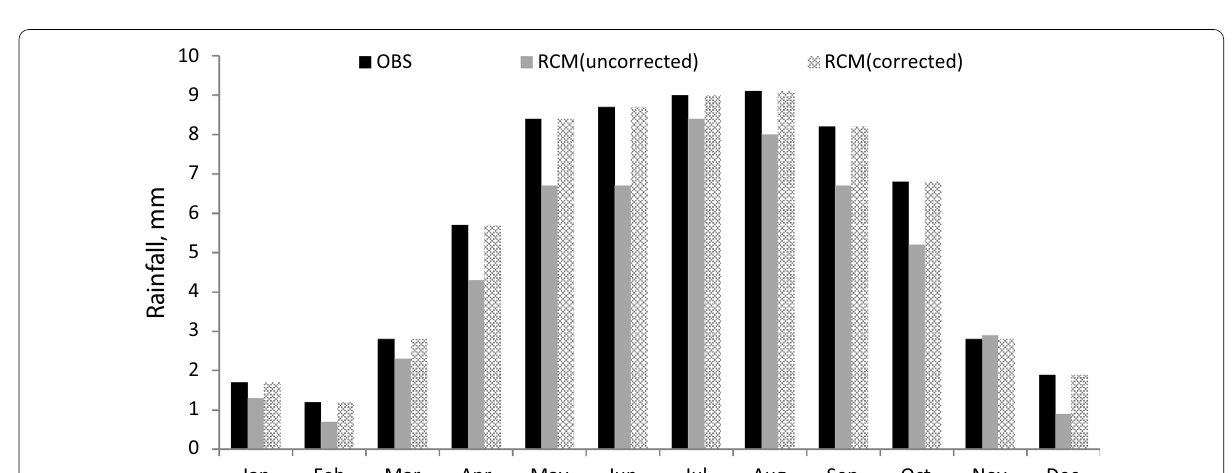
Fig. 3 Comparison of bias corrected and uncorrected RCM precipitation data on the monthly basis